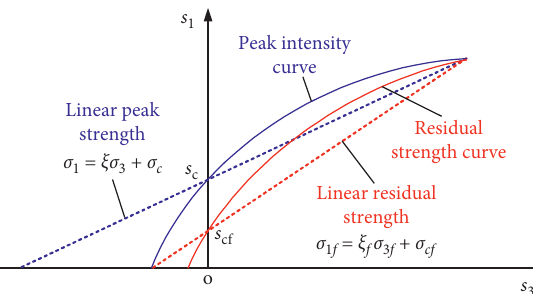
Figure 3: Peak strength and residual strength curve of